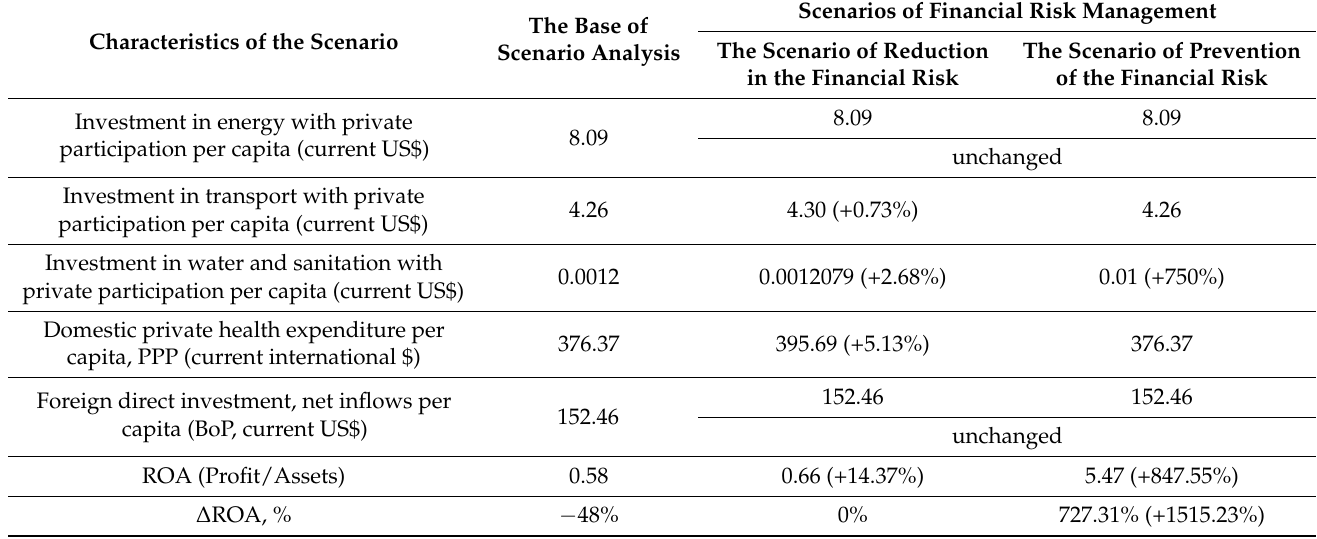
Table 6. Scenarios of financial risk management of companies in 2021 based on the optimization of investment flows in